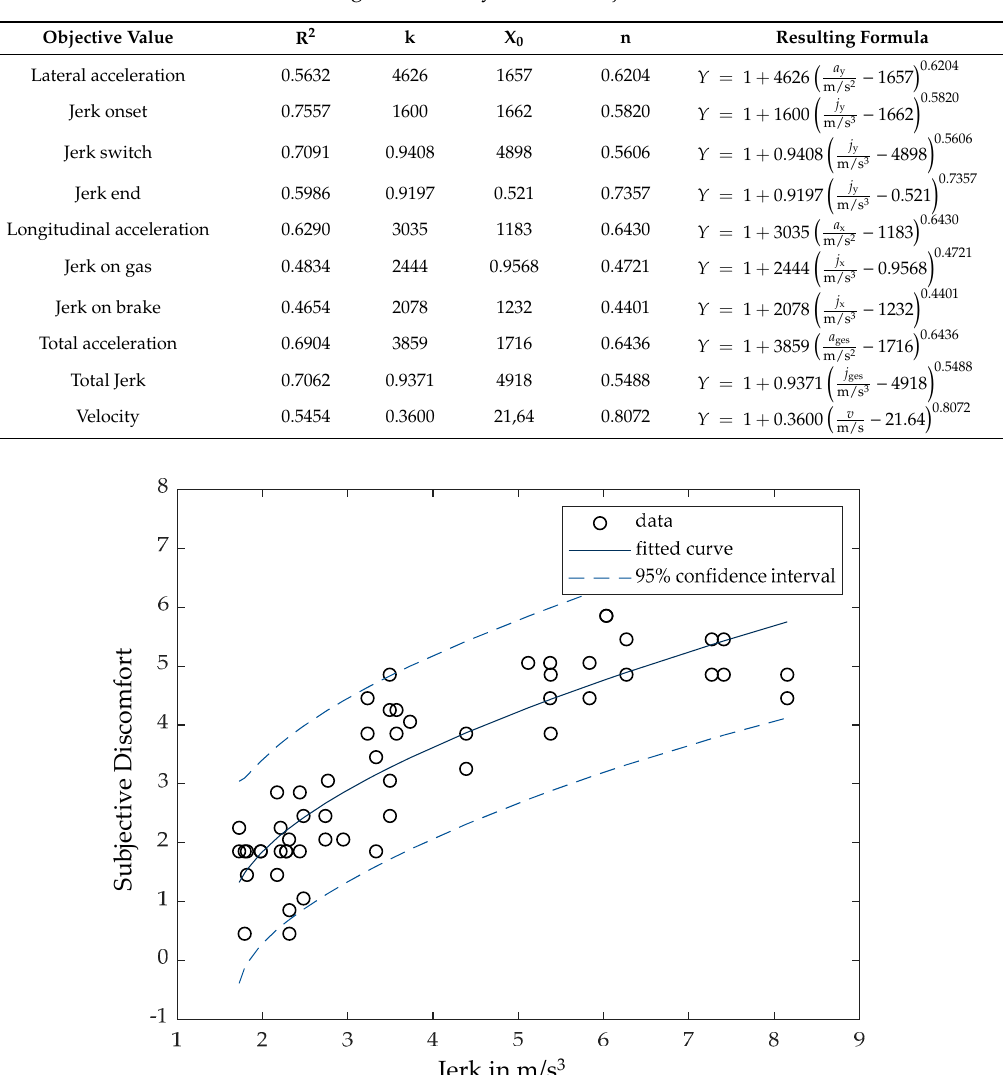
Table 4. Results from the regression analysis for all objective values in Maneuver B.